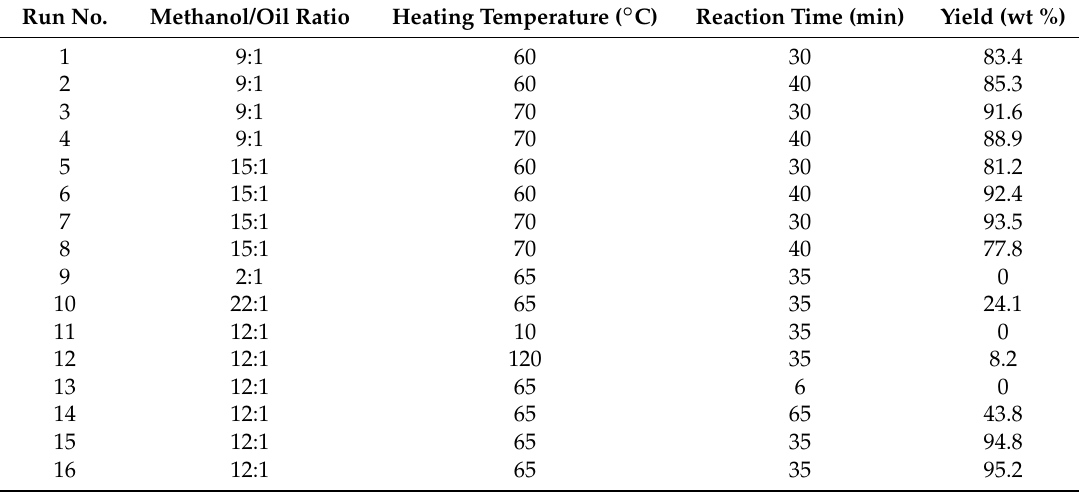
Table 3. Testing conditions in this study.